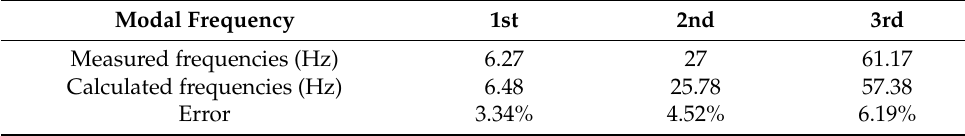
Table 10. Calculated and measured natural frequencies of the test beam.